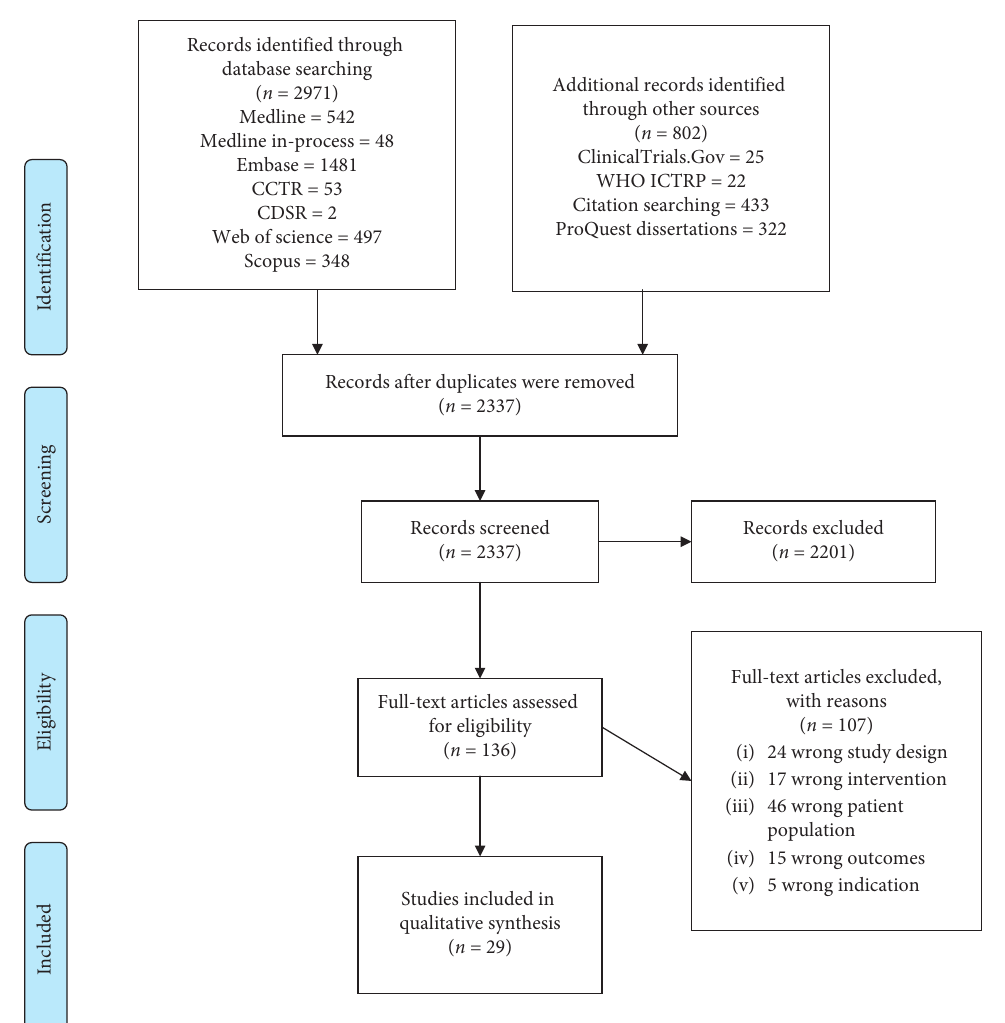
Figure 2: PRISMA flow